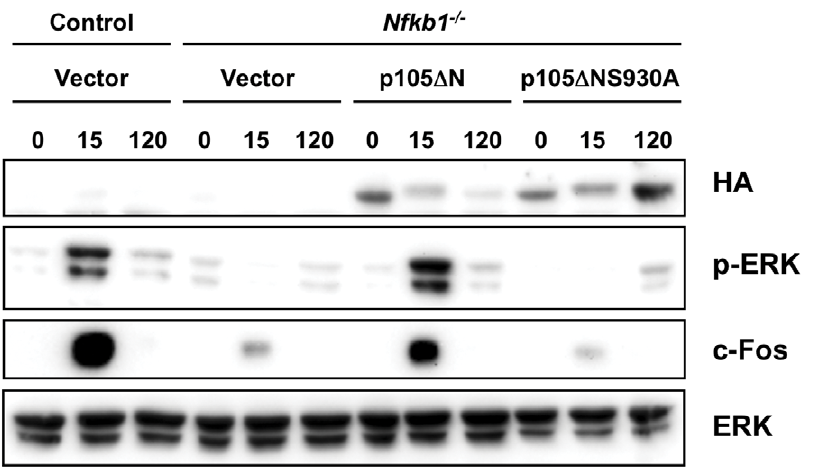
Figure 4. p105 serine 930 is essential for ERK activation and induction of c-Fos. Immunoblotting with indicated antibodies (right) of extracts derived from Il10 2 / 2 Rag2 2 / 2 (control) or Nfkb1 2 / 2 Il10 2 / 2 Rag2 2 / 2 ( Nfkb1 2 / 2 ) BMDM infected with empty vector (Vector) or viruses expressing indicated proteins, prior to stimulation, or at 15 and 120 minutes after LPS stimulation.